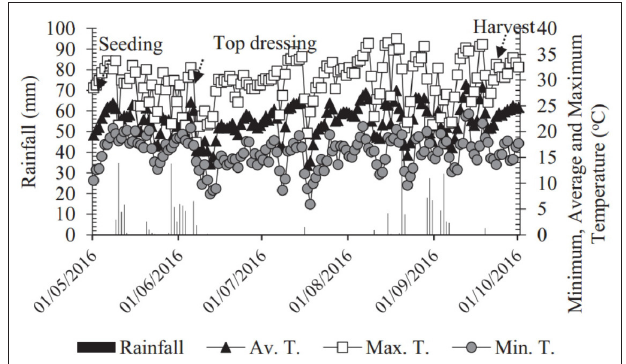
FIGURE 1 | Rainfall and maximum, average, and minimum temperatures obtained from the weather station located at the Education and Research Farm of UNESP during wheat cultivation in the period May 2016 to October 2016.